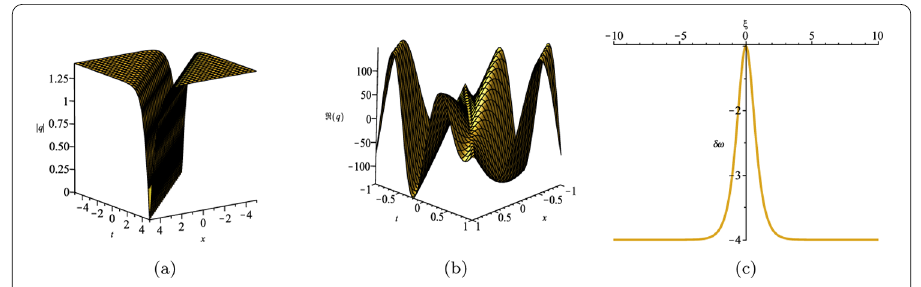
Figure 4 Chirped dark soliton solution (27) with a 1 = 4, a 2 = 1, b = 2, α = 2, λ = 6, μ = 1, ν = 1, σ = 2, Ω = 3. ( a ) Modulus. ( b ) Real part. ( c ) Corresponding chirp